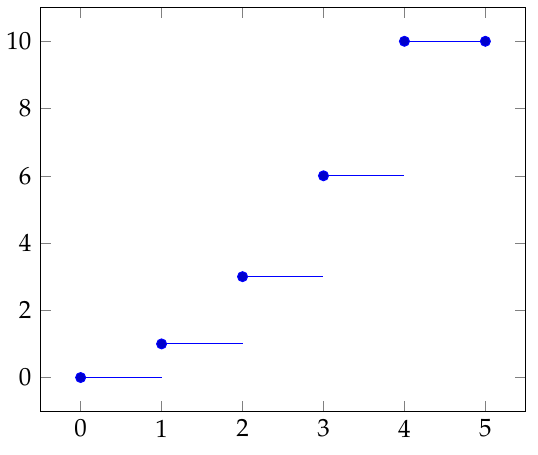
Figure 4. Cádlág function.